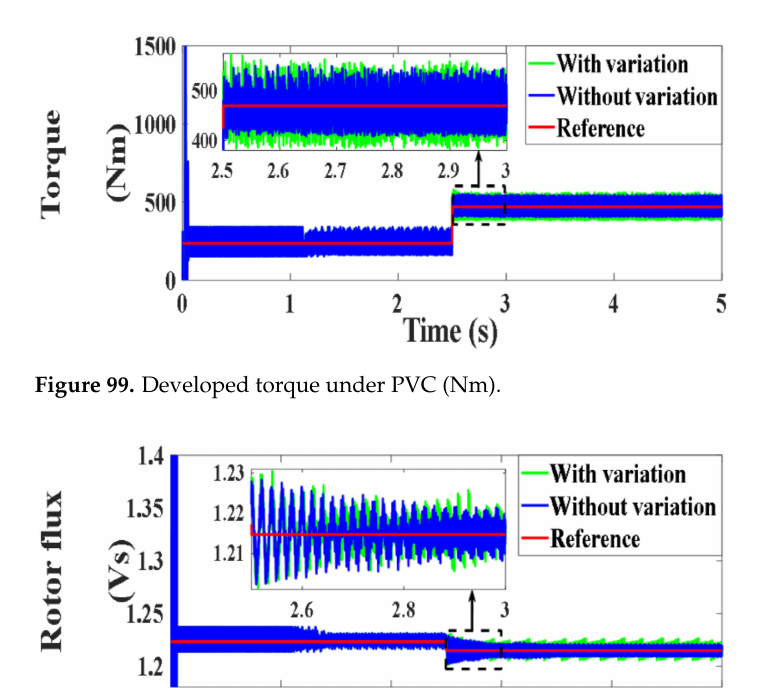
Figure 98. Reactive power under PVC (var).